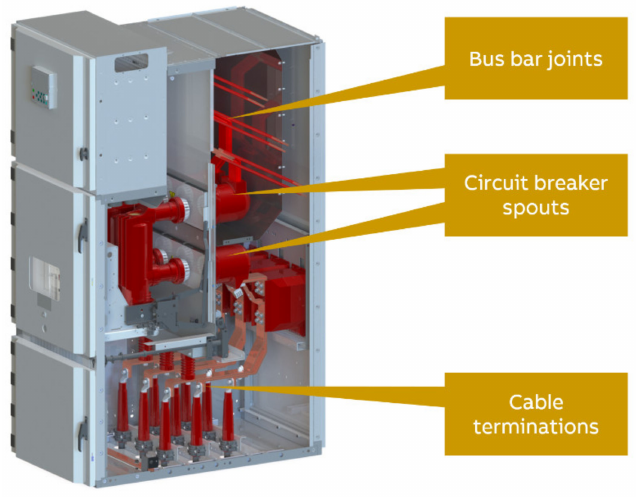
Figure 5. A medium voltage switchgear